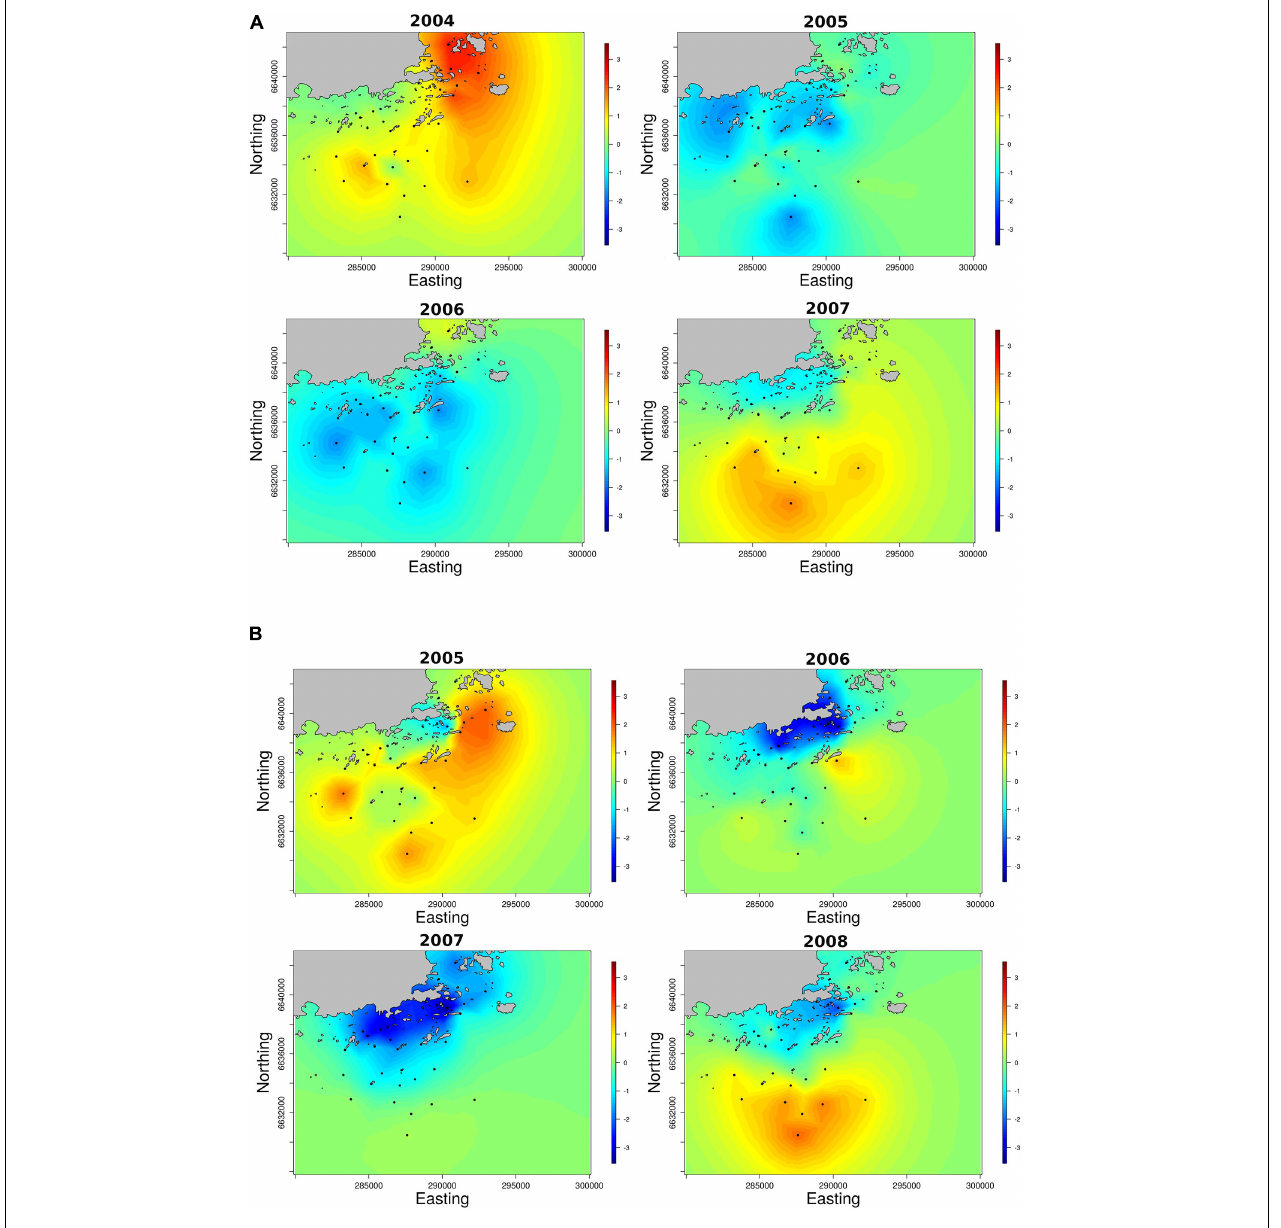
FIGURE 4 | Spatiotemporal distribution of recruits collected from (A) experimental brick collectors in fall and from (B) the benthos in the following spring. Panels show the posterior Gaussian random fields ( w ) for each year in natural log scale. Positive and negative values indicate areas where the recruitment was strong or weak,